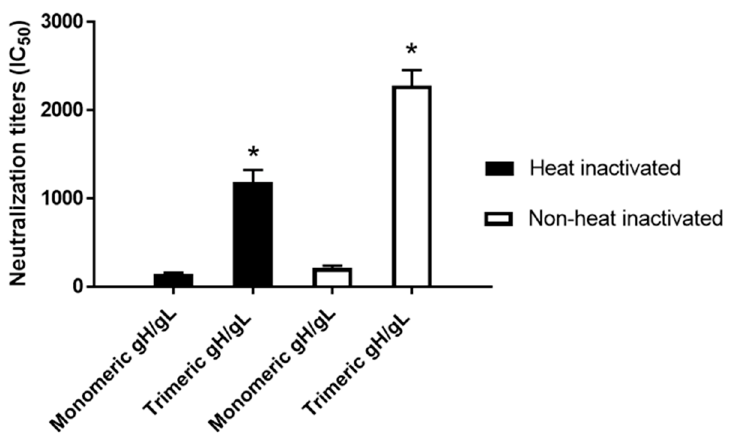
Figure 5. Immunization with HCMV trimeric gH/gL elicited significantly higher complement-dependent and complement-independent serum titers of HCMV-neutralizing activity for fibroblasts compared to monomeric gH/gL immunization. Day 52 pooled sera from five rabbits immunized with 25 µg of HCMV trimeric versus monomeric gH/gL were heat-inactivated (closed bar) or non-heated (open bar), and the IC50 neutralizing activity was determined of each pooled sample in quadruplicate using the MRC-5 fibroblast cell line and HCMV strain AD169 wt131 . Significance * p < 0.05 compared to the sera from mice immunized with HCMV monomeric gH/gL.